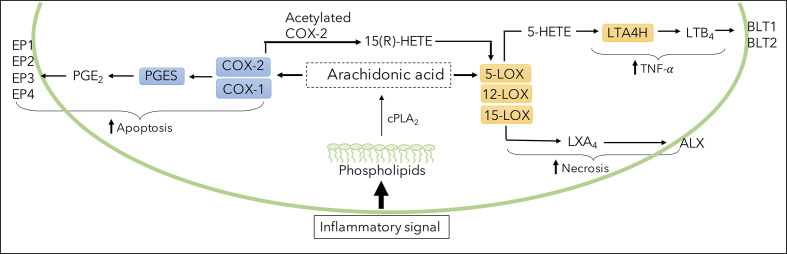
Illustration of eicosanoid biosynthesis. Formation of PGE2, LTB4, and LXA4 through breakdown of arachidonic acid (AA) by cyclooxygenase (COX) and lipoxygenase (LOX) pathways. COX enzymes (constitutive COX-1 or inducible COX-2) and downstream PGES generates PGE2 which binds to various receptors (EP1-EP4). 5-LOX-derived LTB4 is produced via the precursor 5-HETE, converted by enzyme LTA4H and exerts effects through receptors BLT1 and BLT2. LXA4 is derived from LOX enzymes 5,12 and 15-LOX and binds to the ALX receptor.